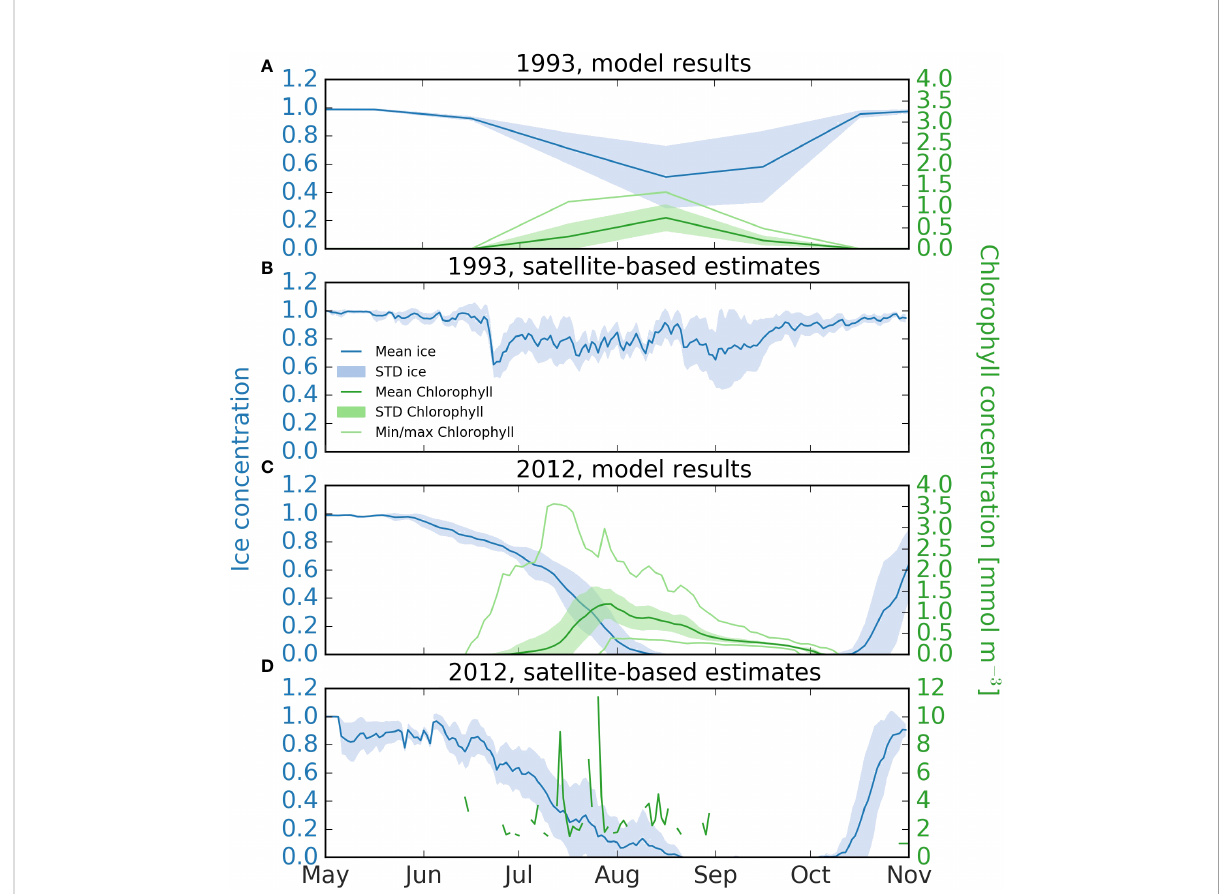
FIGURE 3 Seasonal development of chlorophyll and sea-ice concentration in the study area of the Laptev Sea for 1993 and 2012. (A, C) 2012 and 1993 from model results (Regulated Ecosystem Model REcoM2 coupled to the hydrodynamic model FESOM, a Finite Element Sea-ice Ocean Model). The dark blue line marks mean sea ice concentration, with the standard deviation indicated in light blue. The mean chlorophyll concentration is calculated from the vertical chlorophyll maximum, and is plotted with a dark green line, the corresponding standard deviation is indicated in light green. The maximum and minimum chlorophyll concentrations in the area are plotted as light green lines. For 1993 (A) data are available as monthly means; for 2012 (C) the output is available for every two days. (B, D) 1993 and 2012 from ocean color; NSIDC sea ice concentration (Cavalieri et al., 1996) is plotted as a dark blue line and the standard deviation in light blue. Both sea ice and chlorophyll fi elds are available as daily output, but for chlorophyll no ocean color based products exist for